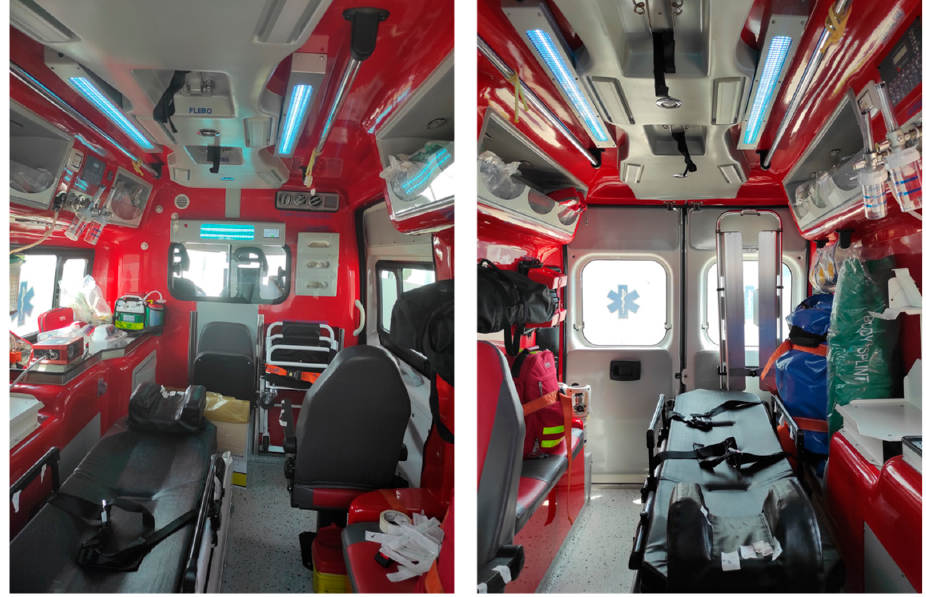
Figure 6. UV-SAN system deployed .